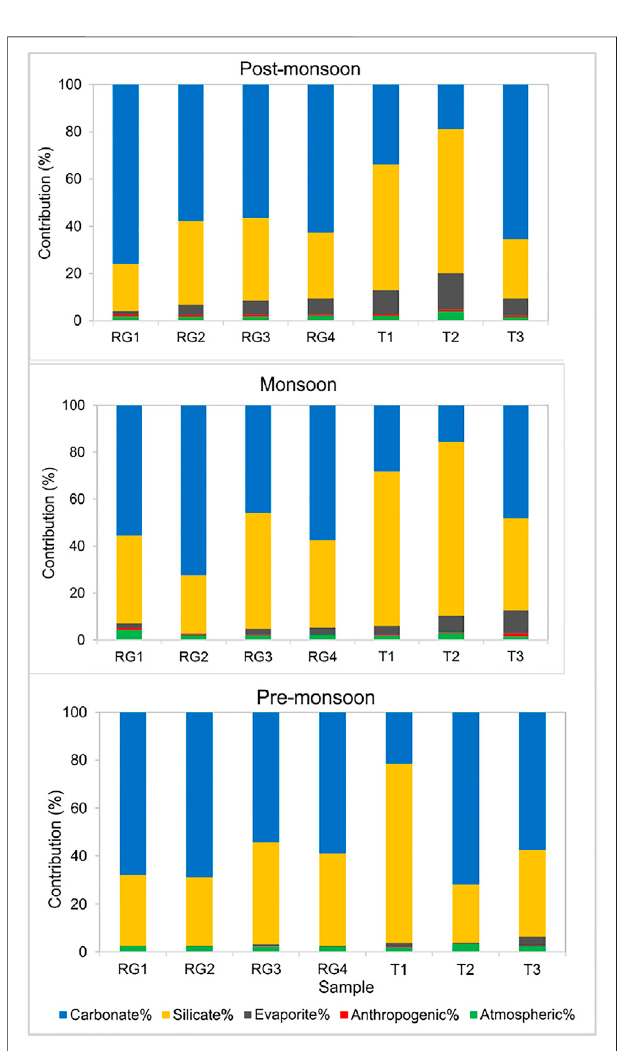
FIGURE 6 | Contribution of different sources to major cation load in pre- monsoon, monsoon, and post-monsoon season in upstream (Zone